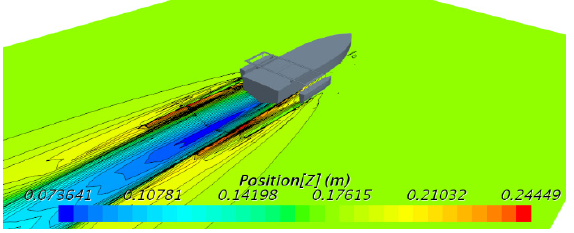
Figure 25. The free surface of the vessel in the TFS when porpoising.